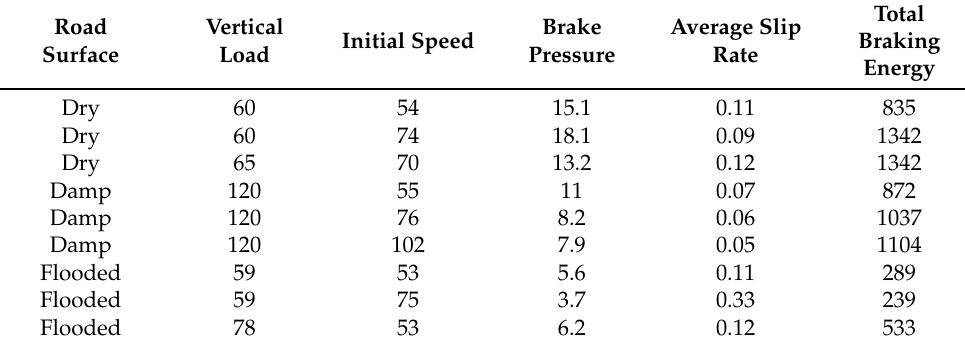
Table 3. Some of the brake test data provided by NASA and FAA.